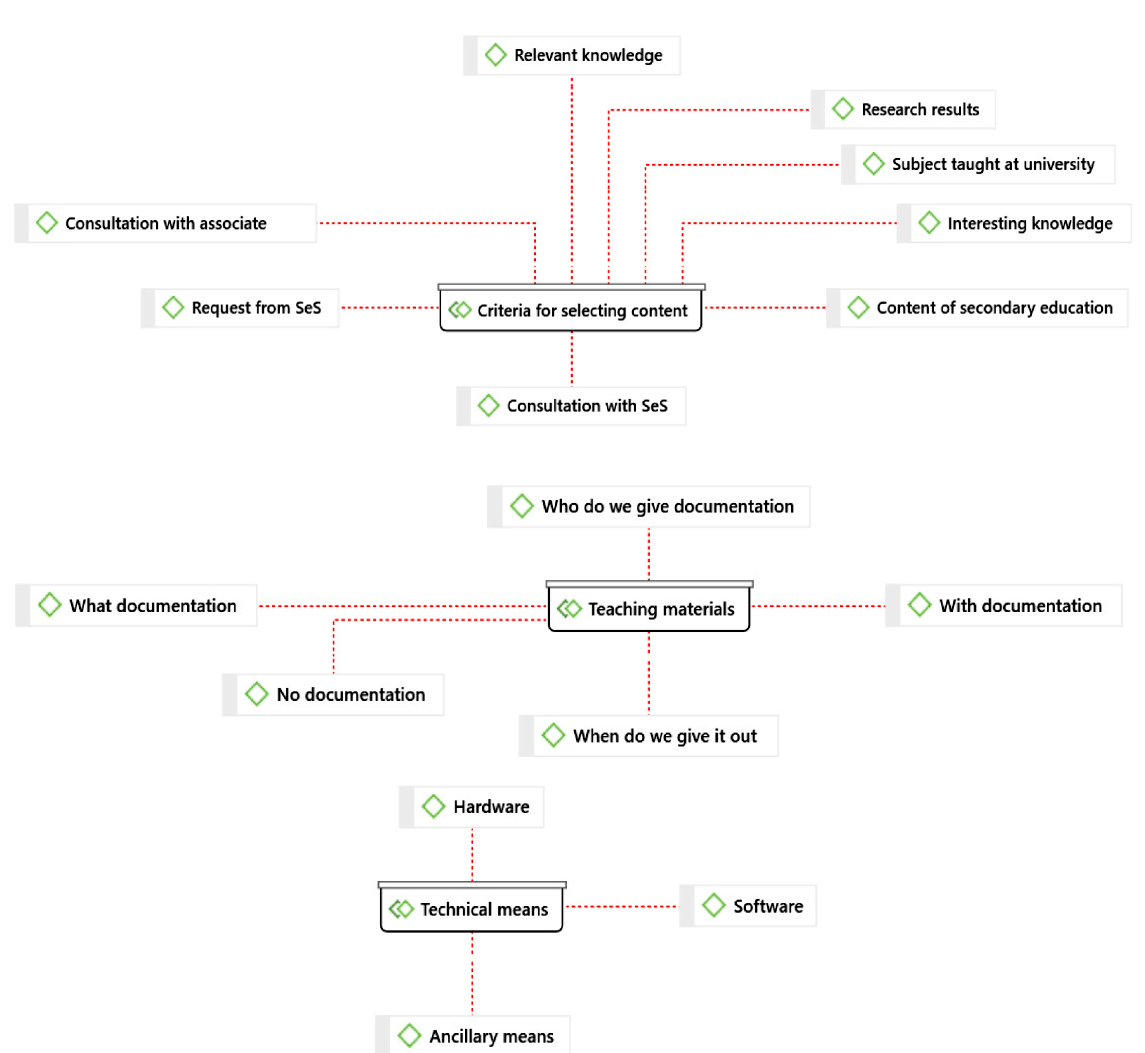
Figure 2. Networks of code groups for Content selection criteria, Teaching material and Technical